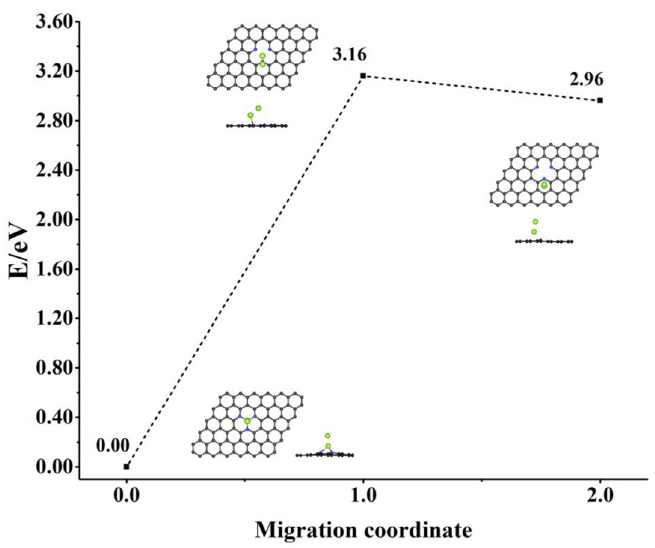
Figure 5. CI − NEB calculation for Re dual-atom migration in Re 2 − SVGN 3 . (Color code: C, black; N, blue; Re, green).